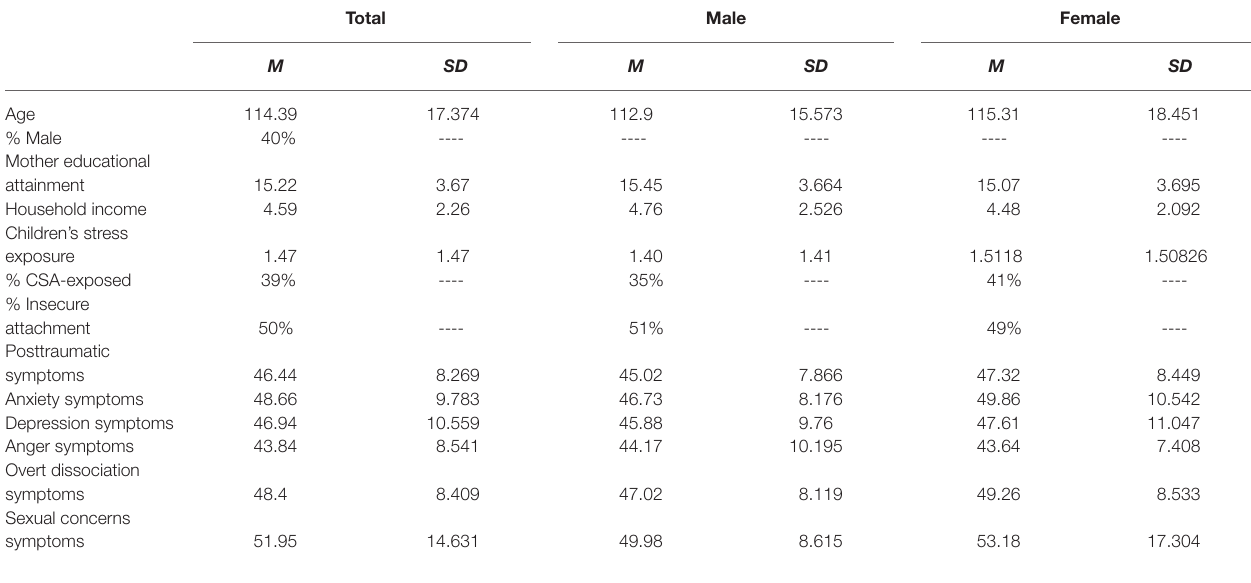
TABLE 1 | Descriptive statistics for key study